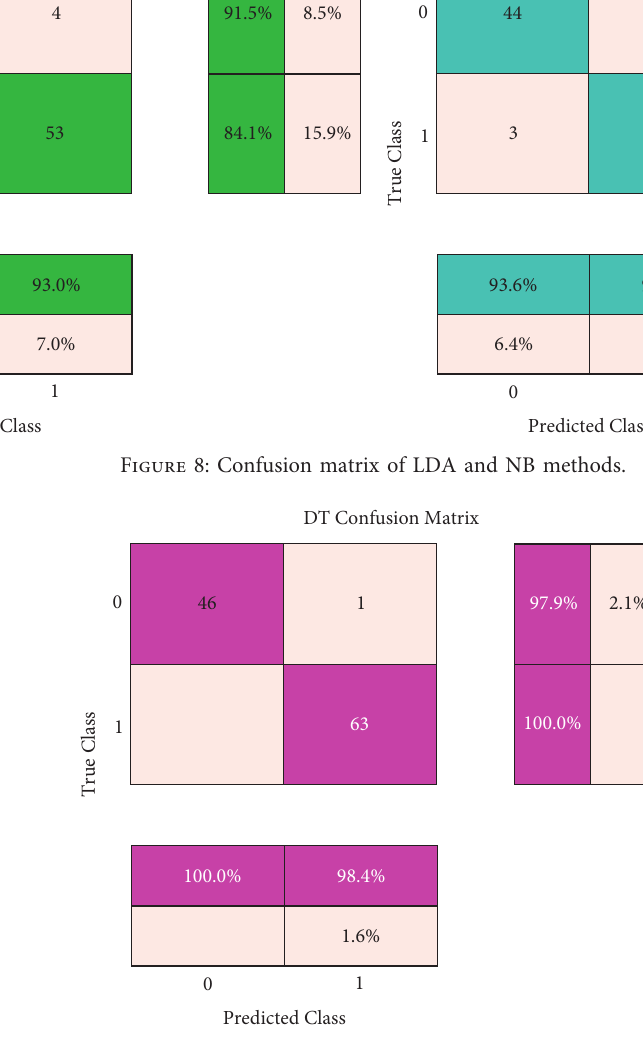
Figure 9: Confusion matrix of DT